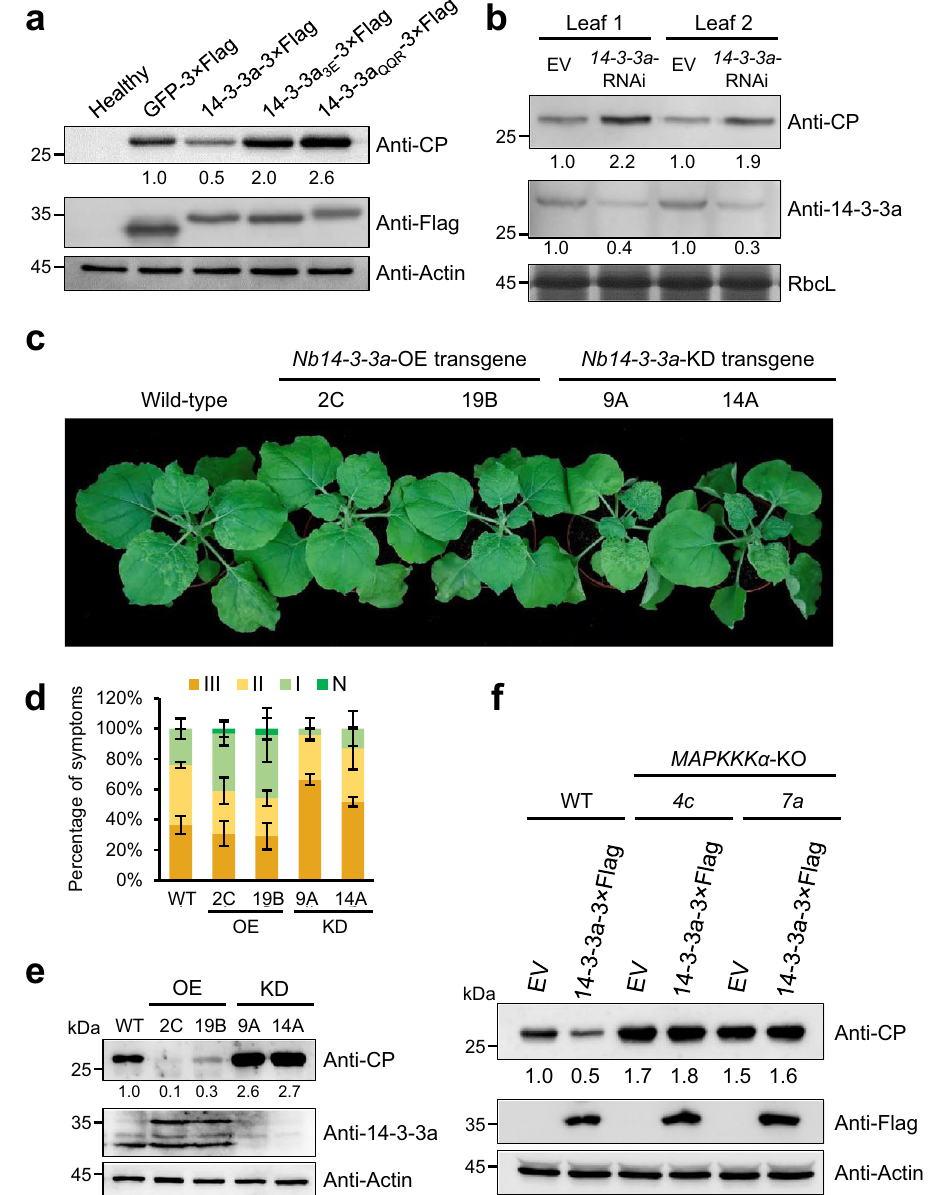
Fig. 5 Nb14-3-3a-mediated antiviral defense depends on the MAPKKK α . a Overexpression of 14-3-3a inhibits BBSV infection. Agrobacterium containing indicated construct above the panel was in fi ltrated into N. benthamiana leaves followed by mechanical inoculation with 300 ng BBSV virions 24 h later. Inoculated leaves were collected at 3 dpi and analyzed by western blot analysis with an anti-CP or anti-Flag antibody. Actin served as the loading control. b Knockdown of Nb14-3-3a increases the accumulation of BBSV. The opposite halves of N. benthamiana leaves were agroin fi ltrated with 14-3-3a -RNAi construct and the control empty vector (EV). Agrobacterium carrying BBSV infection clone was in fi ltrated into the previously in fi ltrated regions 24h later. Leaf samples from in fi ltrated regions were harvested at 3 dpi and subjected to western blot with an anti-CP or anti-14-3-3a antibody. CBB-stained RbcL served as the loading control. For panels a and b , the experiments were repeated three times with similar results. c Phenotypes of BBSV-infected WT, 14-3- 3a -OE, and 14-3-3a -KD plants. N. benthamiana leaves were inoculated with 100 ng BBSV virions. Photographs were taken at 14 dpi and a representative result is shown. d The percentages of BBSV-infected wild-type (WT), 14-3-3a -OE, and 14-3-3a -KD plants with different disease symptom grades. Error bars indicate ± SD of the mean three independent experiments ( n = 3) with at least six plants in each experiment. e Western blot analysis of BBSV CP levels in the indicated plants using an anti-CP or anti-14-3-3a antibody. Actin served as the loading control. f Western blot analysis of BBSV CP levels in the in fi ltrated leaves of WT or NbMAPKKK α -KO plants using an anti-CP or anti-Flag antibody. Actin served as the loading control. For panels e and f , the experiments were repeated three times with similar (Fig. 5c, d). Consistently, BBSV CP accumulated to a signi fi cantly Based on the data presented above, we reasoned that 14-3-3a- lower level in 14-3-3a -OE plants, whereas CP accumulation was mediated defense against BBSV might depend on MAPKKK α . To increased more than twice in 14-3-3a -KD plants in comparison test this hypothesis, we overexpressed 14-3-3a in WT and with the non-transgenic plants (Fig. 5e). Together, these results MAPKKK α - KO plants, and performed BBSV infection assay. demonstrate that 14-3-3a plays an antiviral role in BBSV infection. Western blot analysis showed that overexpression of 14-3-3a in